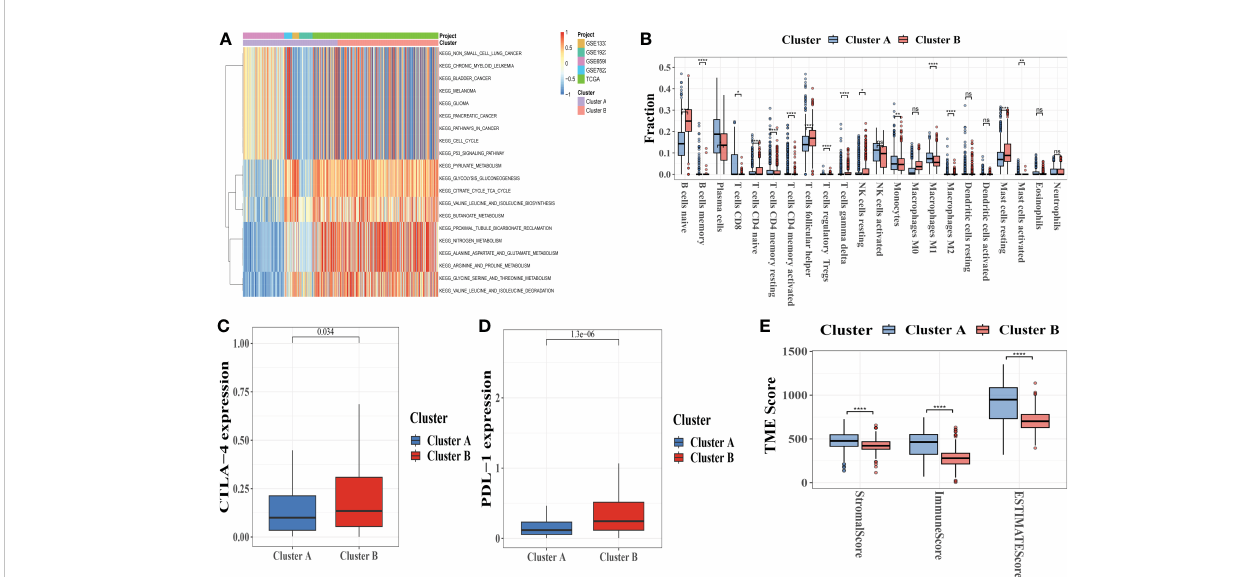
FIGURE 4 Correlations between tumor immune cell microenvironments and two types of melanoma. (A) GSVA of biological pathways between two distinct subtypes, with red representing activated pathways and blue representing inhibited pathways, respectively. (B) The presence of 22 different types of in fi ltrating immune cells in the two CRC subtypes. (C, D) CTLA-4 and PD-L1 expression levels in two melanoma subtypes. (E) Correlations between the two types of melanoma and the TME score. GSVA, gene set variation analysis; TME, tumor microenvironment. *p-value<0.05, **p-value<0.01,